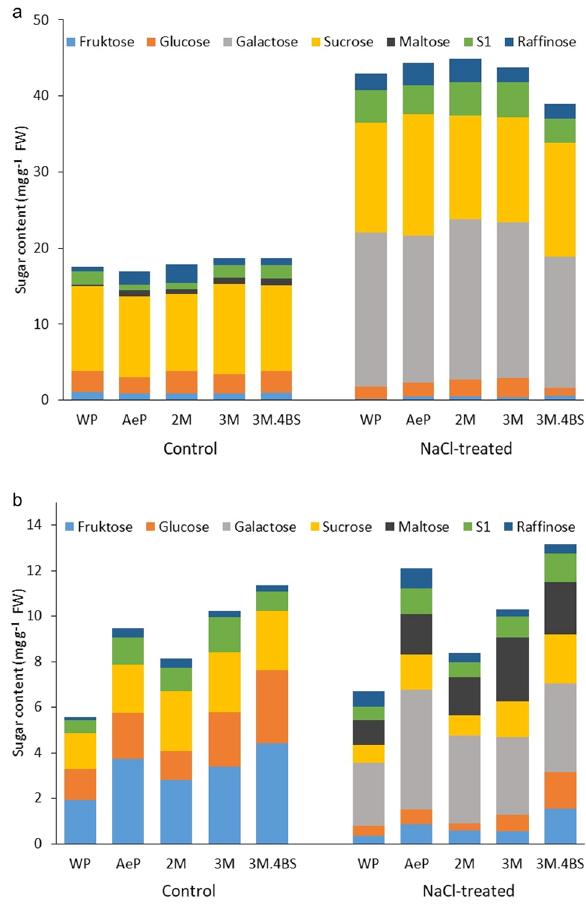
Figure 6. Sugar composition in the leaves ( a ) and roots ( b ) of different genotypes grown in hydroponic solution with and without salt treatment. WP–wheat parent; AeP— Aegilops parent and addition lines. Data are mean ± standard deviation of five replicates per treatment. Values and the results of statistical analysis using Tukey’s post hoc test are presented in Supplementary Table S4. Data are mean ± standard deviation of five replicates per